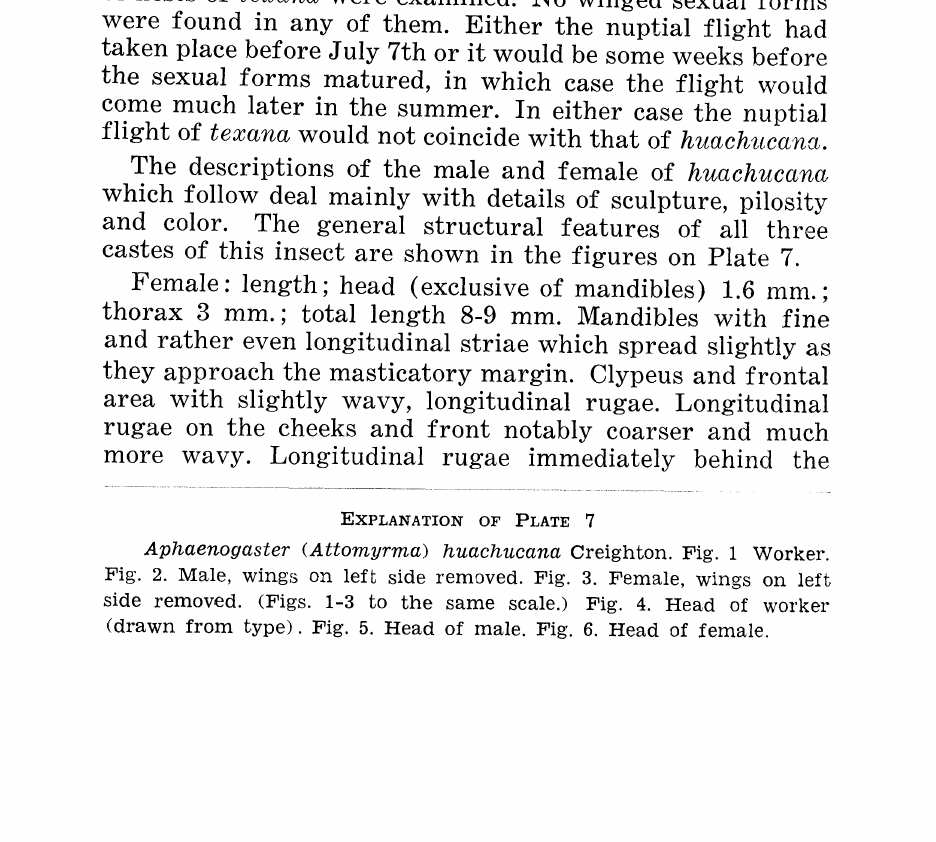
Fig. 2. Male, wings on left side removed. Fig. 3. Female, wings on left side removed. (Figs. 1-3 to the same scale.) Fig. 4. Head of worker (drawn from type). Fig. 5. Head of male. Fig. 6. Head of